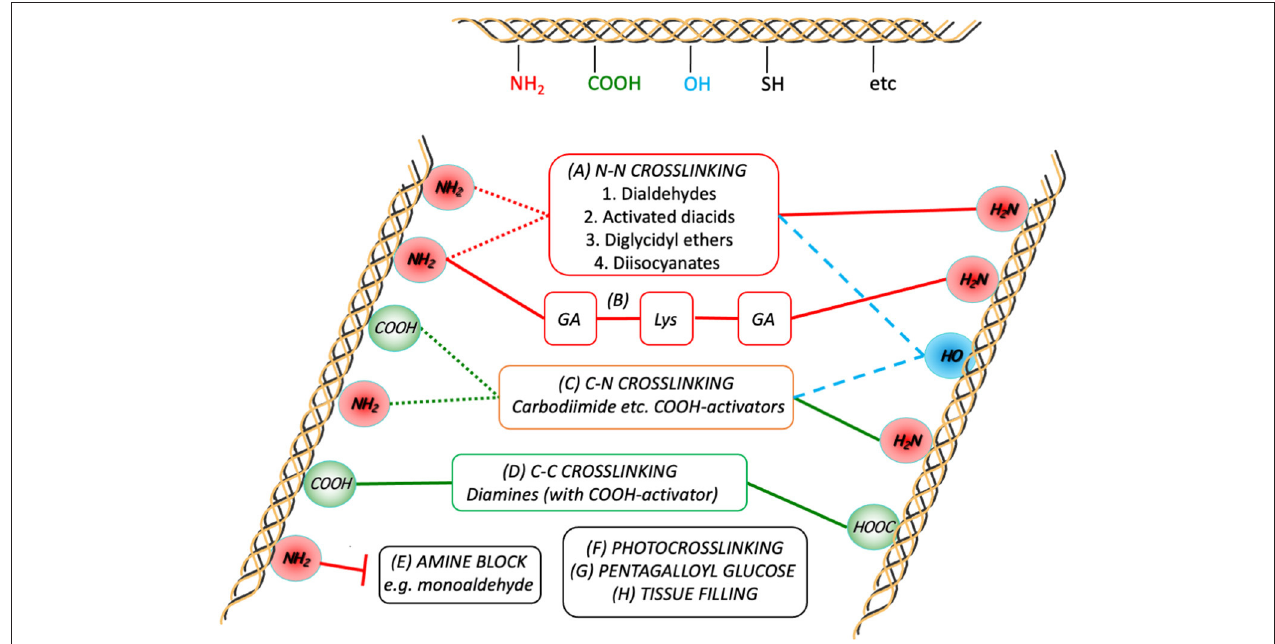
FIGURE 4 | Schematic representation of the crosslink chemistries as they relate to the major participating functional groups on the collagen chains. Although GA crosslinking (A) is complex, it is generally agreed to form inter- (and intramolecular; dotted red lines) links predominantly between the ε -amino groups of the lysines present in the peptide. Combining GA crosslinking with addition of lysine is also shown in (B) . Diamines are typically used to form intermolecular crosslinks between carboxylic acid groups (from Glu and Asp) after activation of the latter toward nucleophilic attack (D) . Some treatments use activated diacids to crosslink between the amines (A2) , sometimes in combination with (D) . In either (A2) or (D) , subject to sufficient proximity, activated tissue COOH-groups can also react with tissue NH 2 -groups on the same or other chains (C) . In order to prevent the participation of tissue amines in the crosslinking process, they can be pre-blocked (E) . The potential for participation of hydroxyl groups with the activated COOH or other electrophiles is also indicated (dashed blue